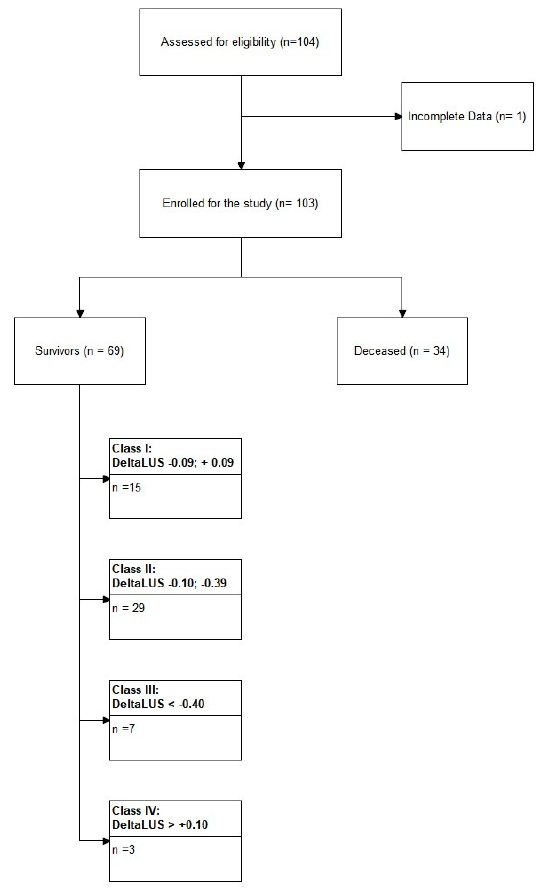
Figure 1. Flowchart of the enrollment process. Surviving patients show an additional 4 classes based on the extent of ∆ LUS score magnitude. ∆ LUS = delta lung ultrasound. Table 1. Clinical, laboratory and anthropometric characteristics of the general population ( n = 103) and subgroups (surviving patients, n = 69; and deceased, n = 34) compared by Student’s t